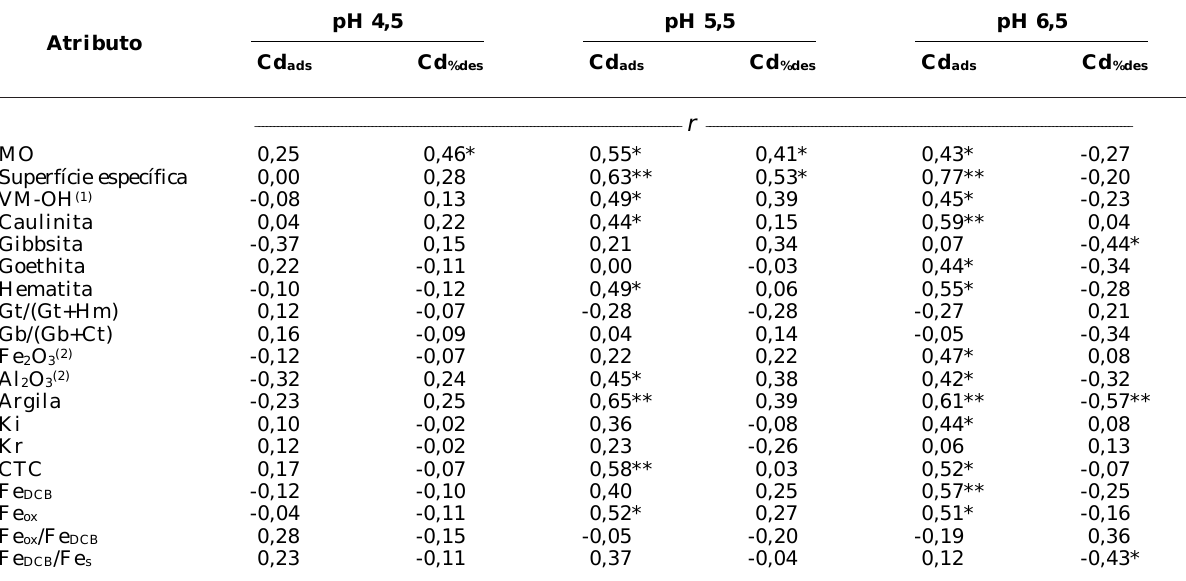
(1) Vermiculita com hidroxi entre-camadas. (2) Extraído pelo ataque sulfúrico; Fe nato; Fe = Ferro extraído pelo oxalato de amônio; Fe ox